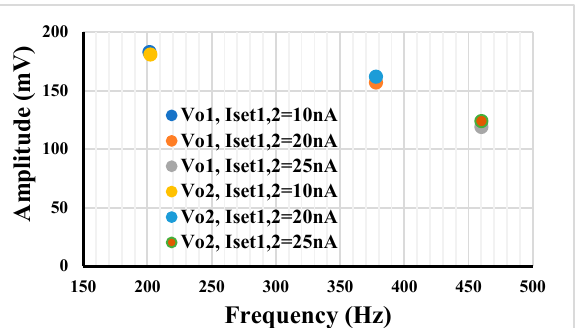
Figure 10. The amplitudes of V o1 and V o2 versus the oscillation frequencies ( a ) varying by R 1 , and ( b ) varying by g m 4 via I set4 .